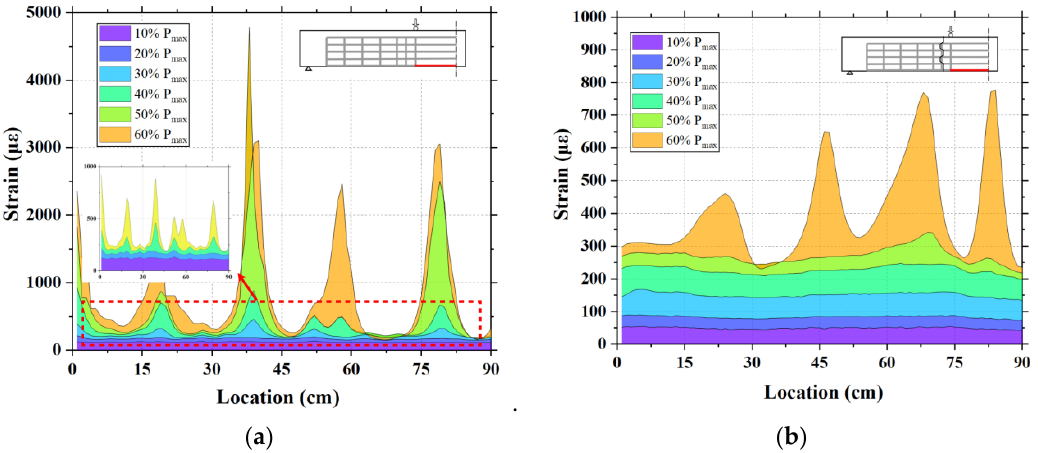
Figure 7. Strain profile at the bottom of the mid-span under the rising load, corresponding to the V1 sensor: ( a ) cast-in-place cap beams; ( b ) precast cap beams.